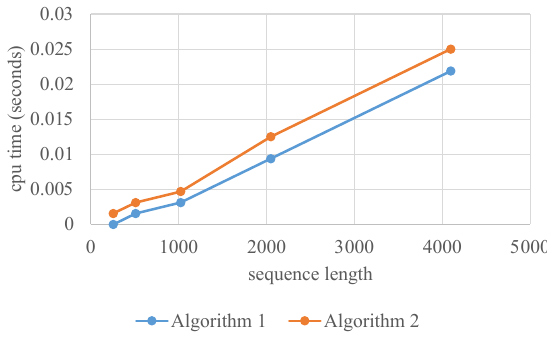
Figure 8. Average CPU time for LCC case with sequences of 2048 character long String